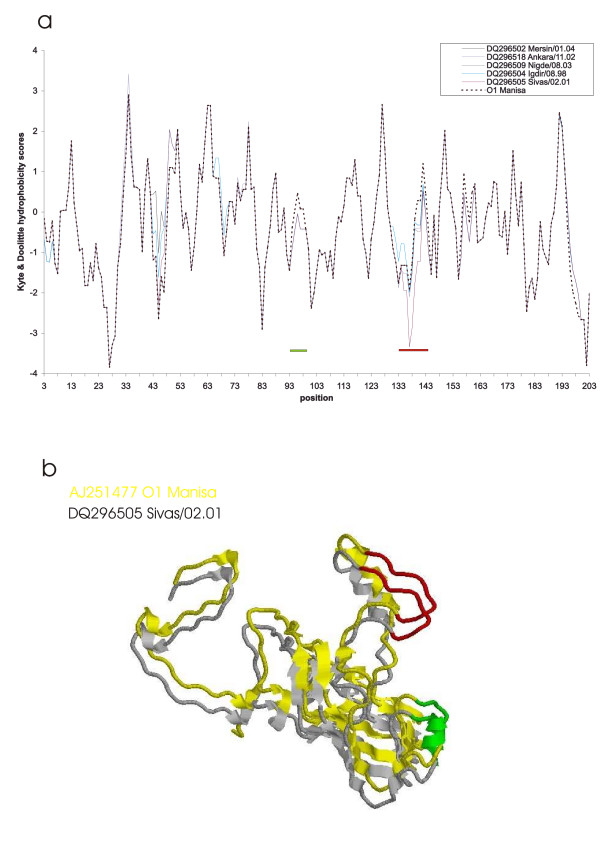
Amino Acid Hydrophobicity plot (a) and structural alignment (b) based on the consensus sequences of the main serotype O subtypes. Significant differences are indicated by coloured bar, where the colour refers to the part of the structural model.